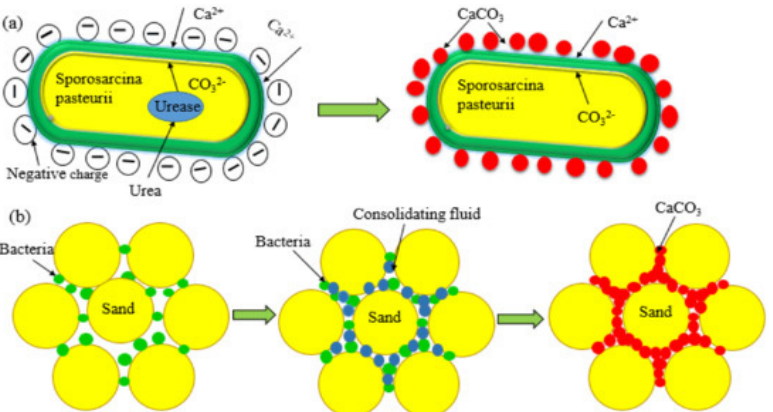
Figure 1. Schematic diagram of microbial solidified sand: ( a ) Microbial calcium carbonate production mechanism; ( b ) Calcium carbonate cemented sand granules